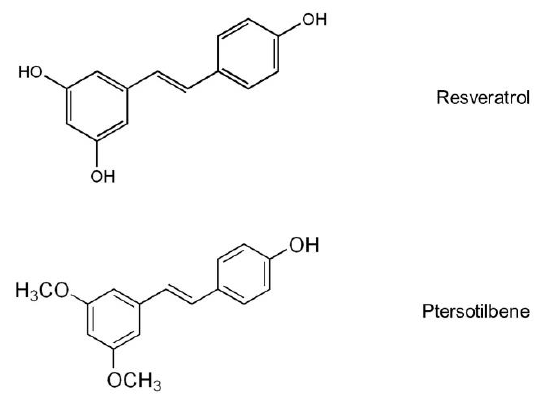
Figure 1. Resveratrol and pterostilbene chemical